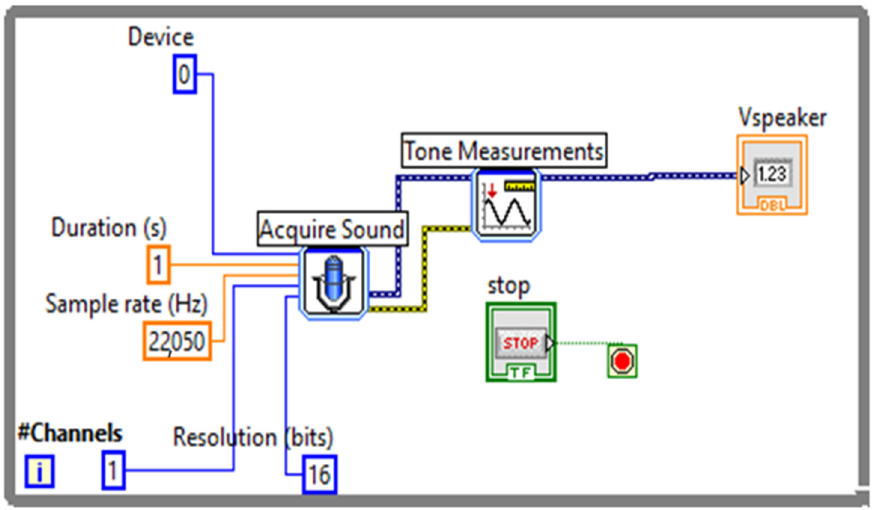
Figure 5. Simple virtual instrument (VI) to acquire the microphone signal.